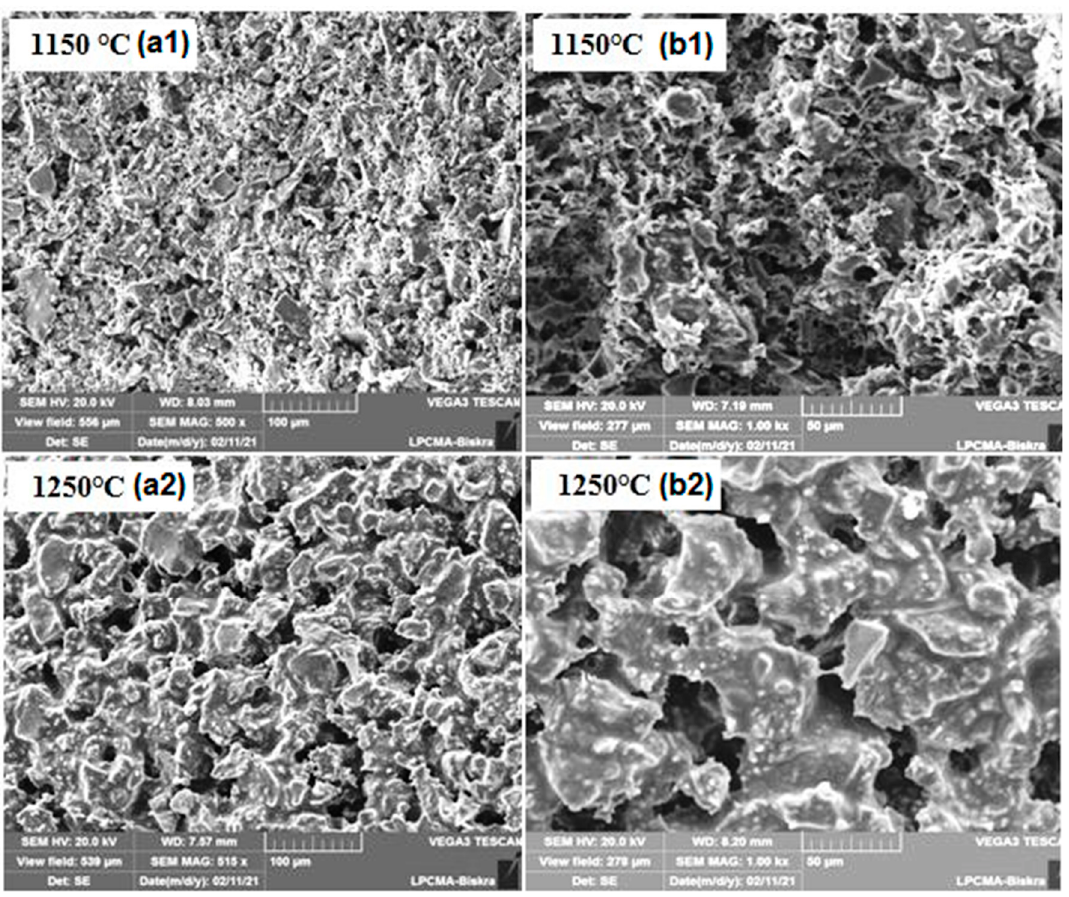
Figure 7. SEM micrographs of membrane supports sintered for 1 h at 1150 and 1250 °C, ( a1,a2 ) surface and ( b1,b2 ) cross-section.